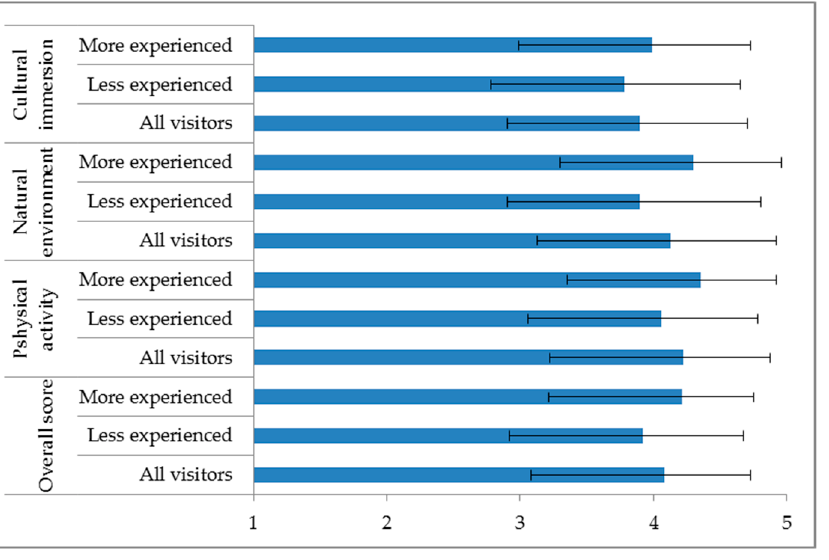
Table 2. Importance of motives for visiting a national or natural park.